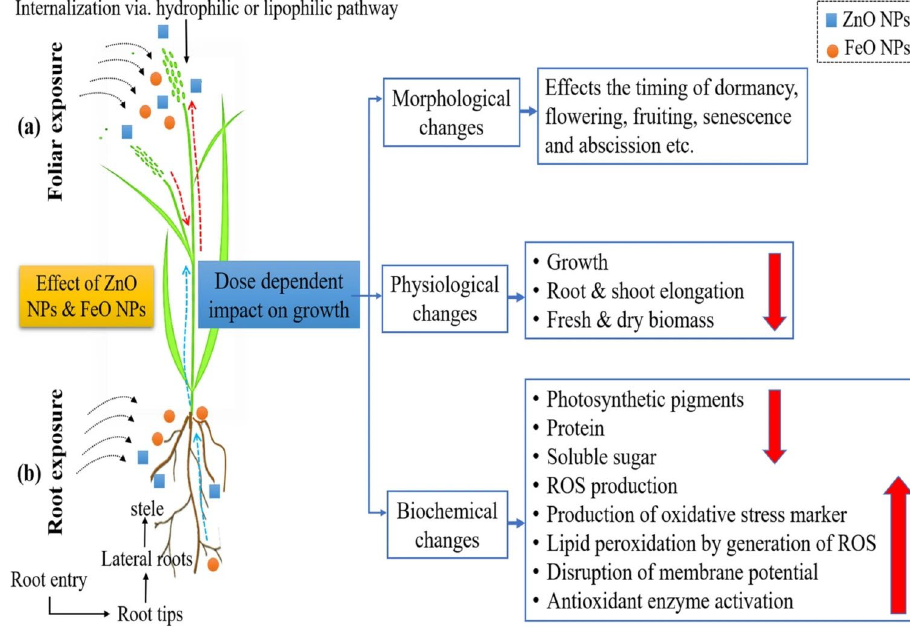
Figure 7. Schematic representation of the dose-dependent effects of ZnO and FeO NPs on morpho- logical, physiological, and biochemical changes in rice crops, ( a ) foliar exposure of NPs via. lipophilic pathway; ( b ) uptake of NPs from soil in the root system. Reprinted with permission from Ref. [64]. 2021, Springer-Verlag.